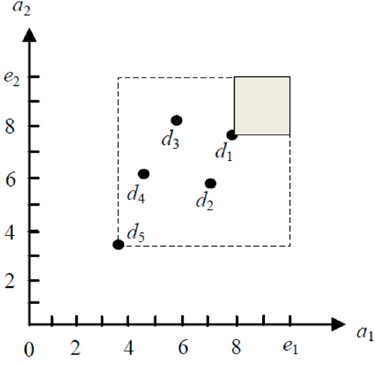
Figure 3. Illustration of dominant capability.